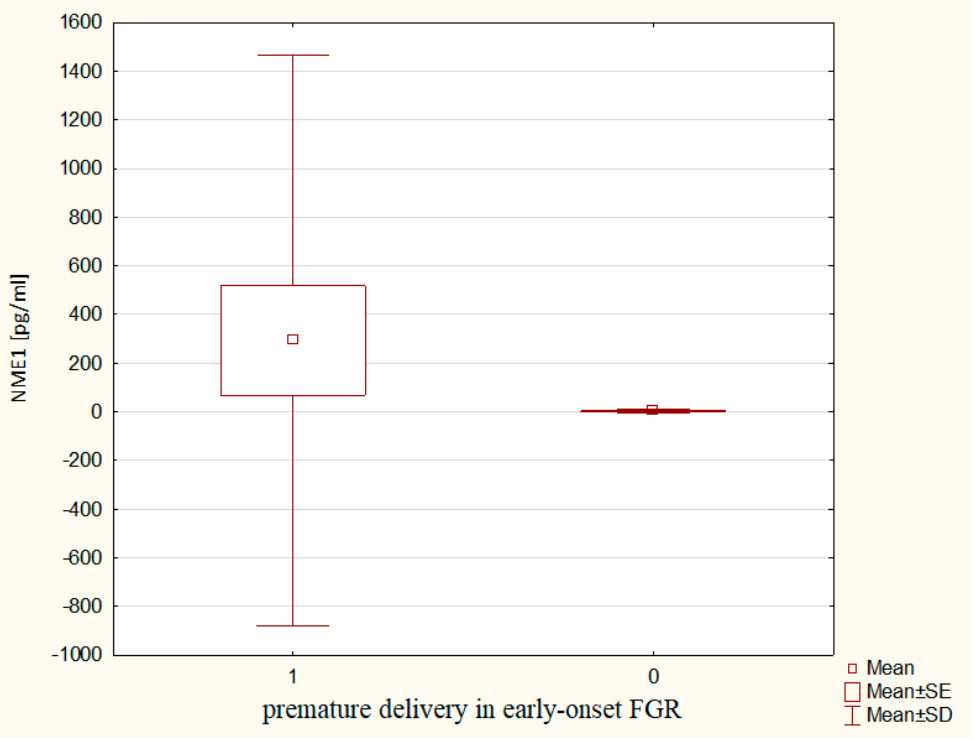
Figure 3. The maternal serum NME1 concentrations in relation to premature delivery in the early- onset FGR.